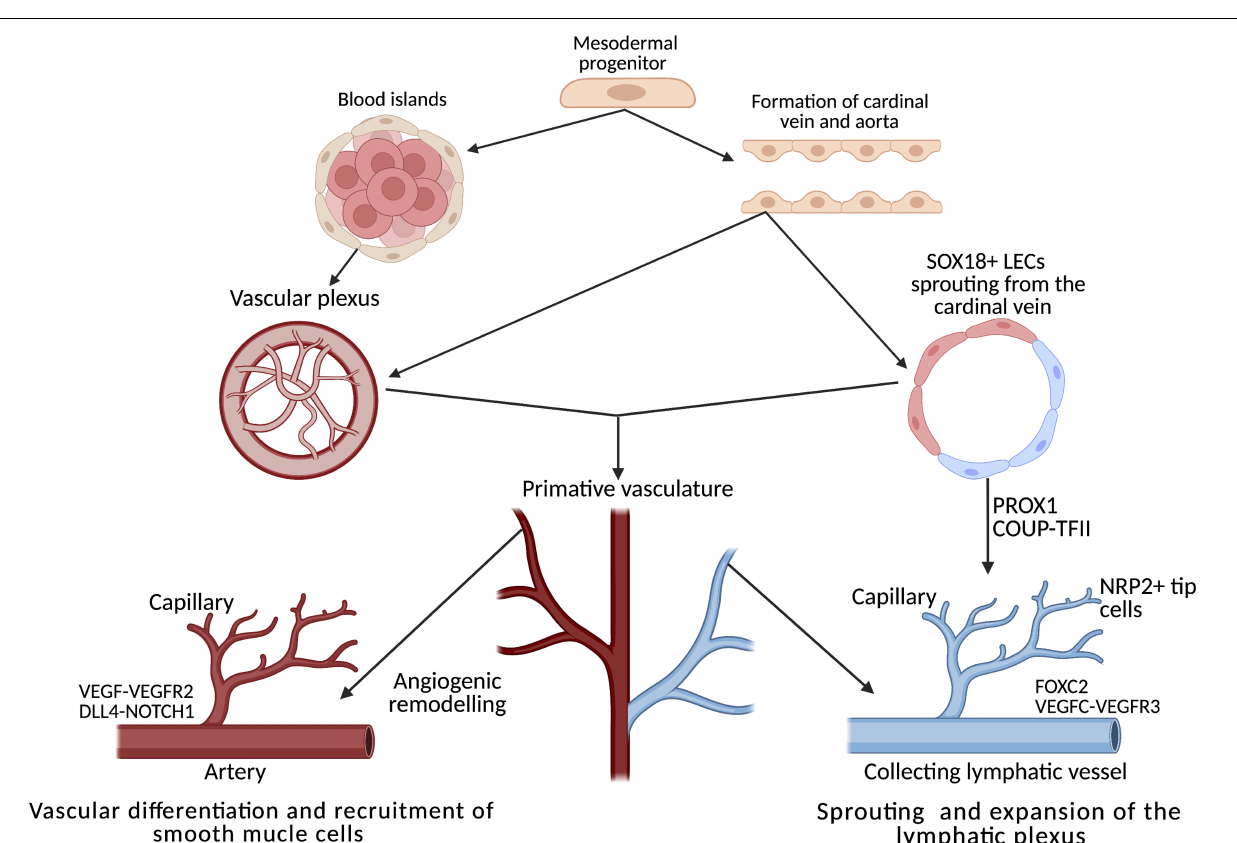
FIGURE 2 | Development, differentiation and separation of the blood and lymphatic networks. Both networks originate from progenitors in the mesodermal layer of the embryo. From the primitive vascular plexus, transcription factors activate the innate genetic programme, resulting in extensive remodelling cascades throughout embryogenesis, forming two distinct networks of vessels. In the heart, the lymphatic plexus is remodelled and guided by tissue-resident macrophages through direct interaction between the lymphatic endothelial cells and the macrophages. Adapted from De Val and Black (2009) and Adams and Alitalo (2007). Created using